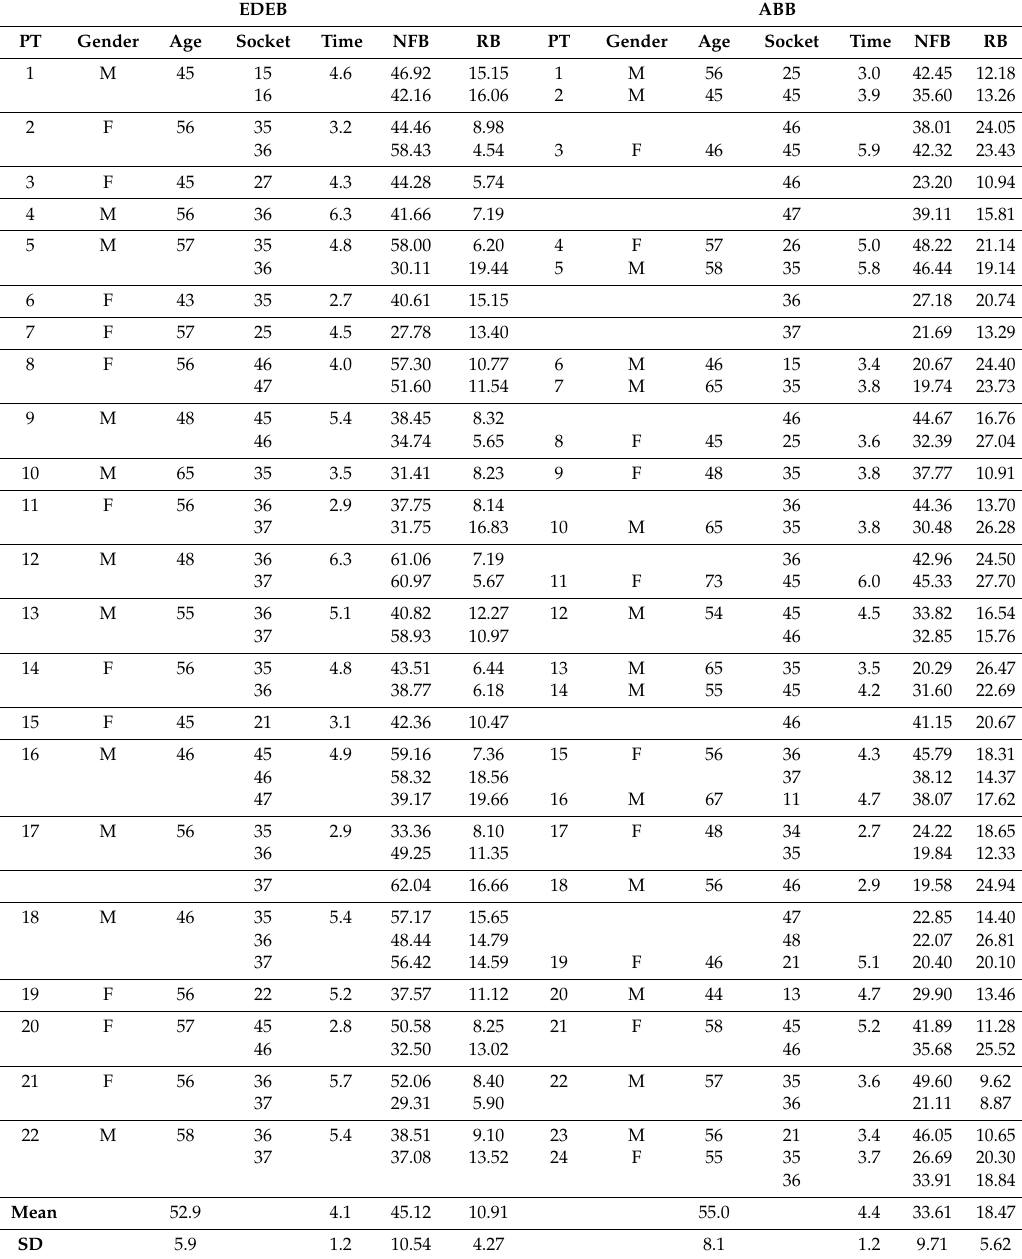
Table 1. Summary of data and results of the present